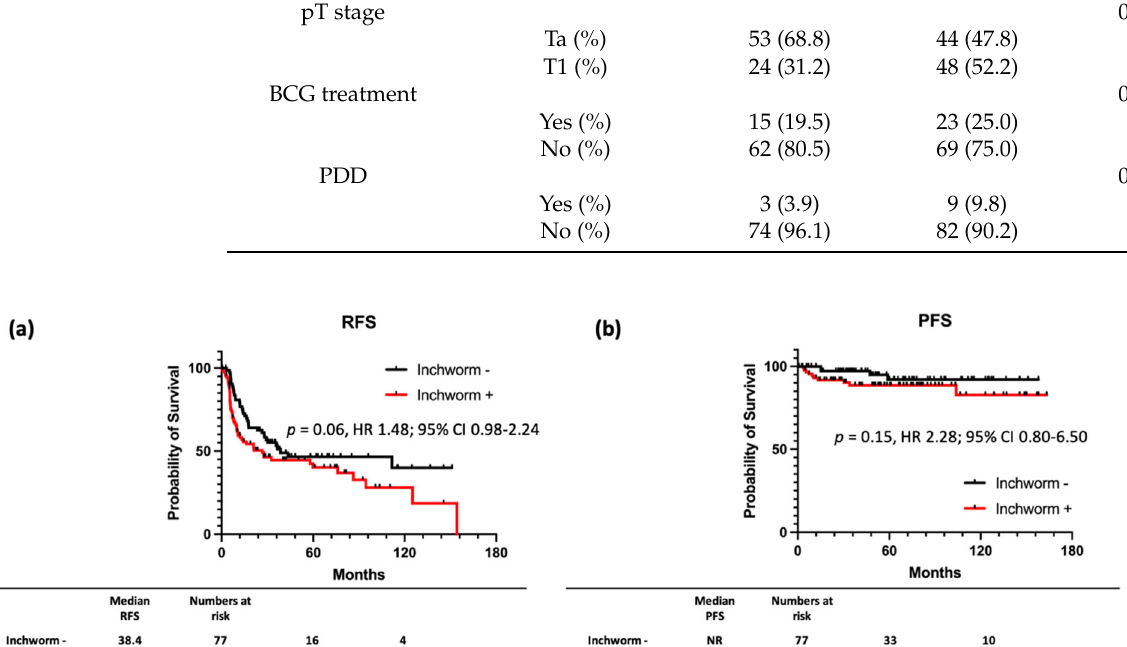
Figure 4. Kaplan − Meier survival curves for recurrence − free survival and progression − free survival stratified by the presence of an inchworm sign for patients with pTa and pT1. Patients with NMIBC are compared for RFS and PFS with and without inchworm sign in pTa and pT1. In patients with pTa, RFS tends to be worse in those with inchworm sign; however, the difference is not significant ( a ). No other comparisons are significantly different ( b − d ). 3.4. Prognostic Factors for RFS and PFS of Patients with NMIBC with/without Inchworm Sign We focused on patients with NMIBC with inchworm sign and investigated the prog ‐ nostic factors for RFS and PFS. We identified positive cytology (HR: 1.90, 95% CI: 1.04– 3.48; p = 0.04) as a predictor for RFS (Table 4). Conversely, no prognostic factors for PFS